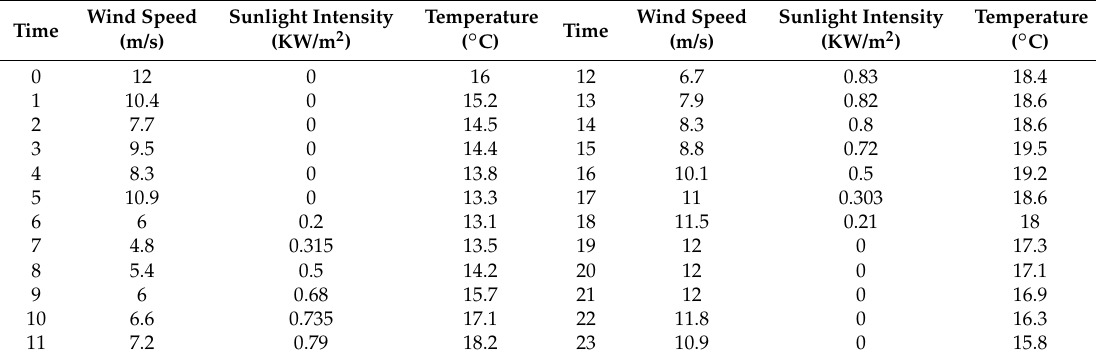
Figure 9. Renewable energy generation curves.